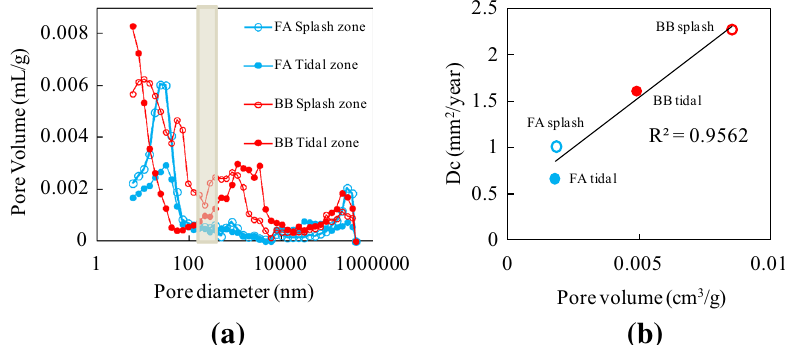
Fig. 11 An example showing the determination of R 2 between D c and pore volume, a pore distribution of concretes exposed to marine conditions and b D c versus pore volume for all concretes between pore size of 200–500 nm.